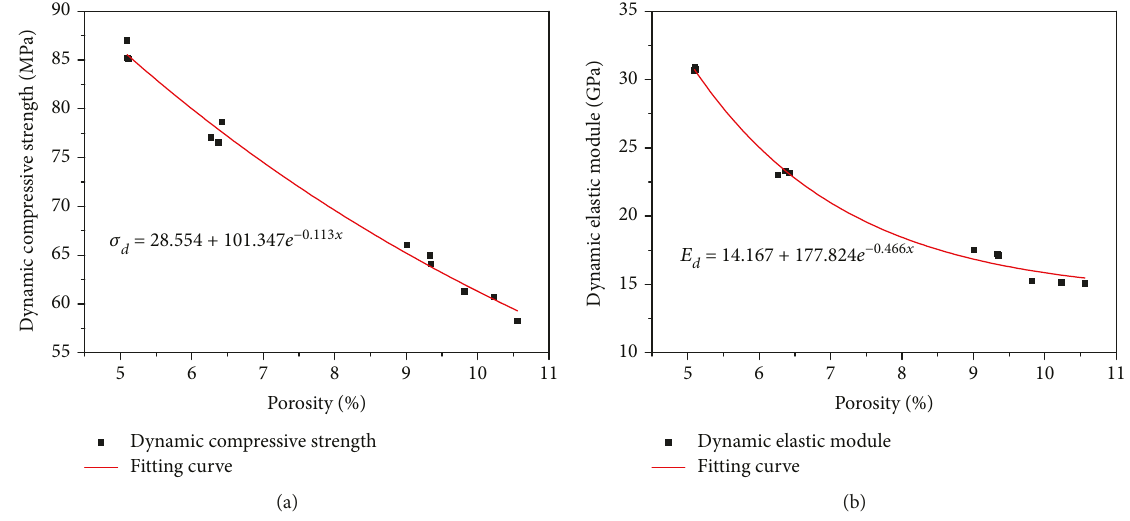
Figure 13: Relationship of porosity and dynamic mechanical properties. Table 5: Comparison of tested results and predicted